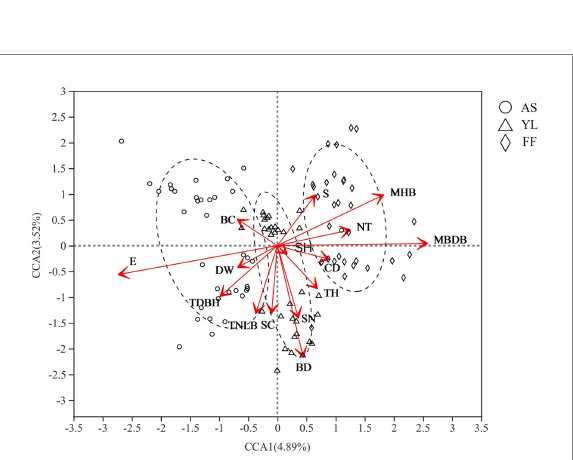
FIGURE 4 CCA analysis of environmental factors and phyllosphere fungal community among AS, YL, and FF. E, elevation; DW, water source distance; TDBH, trees diameter at breast height; TNLB, total number of live bamboo; SC, shrub coverage; BD, bamboo deaths; SN, shrubs numbers; TH, trees height; SH, Shrub height; CD, canopy density; MBDB, mean base diameter of bamboo; NT, number of trees; MHB, mean height of bamboo; S, Slope; BC, bamboo